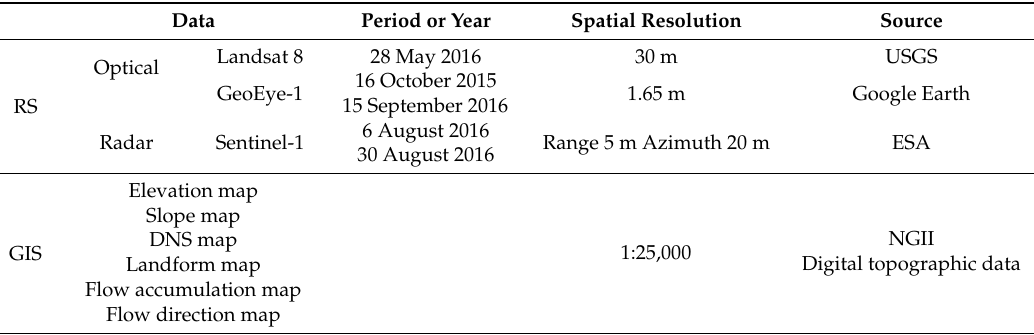
Table 1. Databases in this study. DNS: distance from the nearest stream, ESA: European space agency, GIS: geographic information system, NGII: national geographic information institute, RS: remote sensing, USGS: United States geological survey.